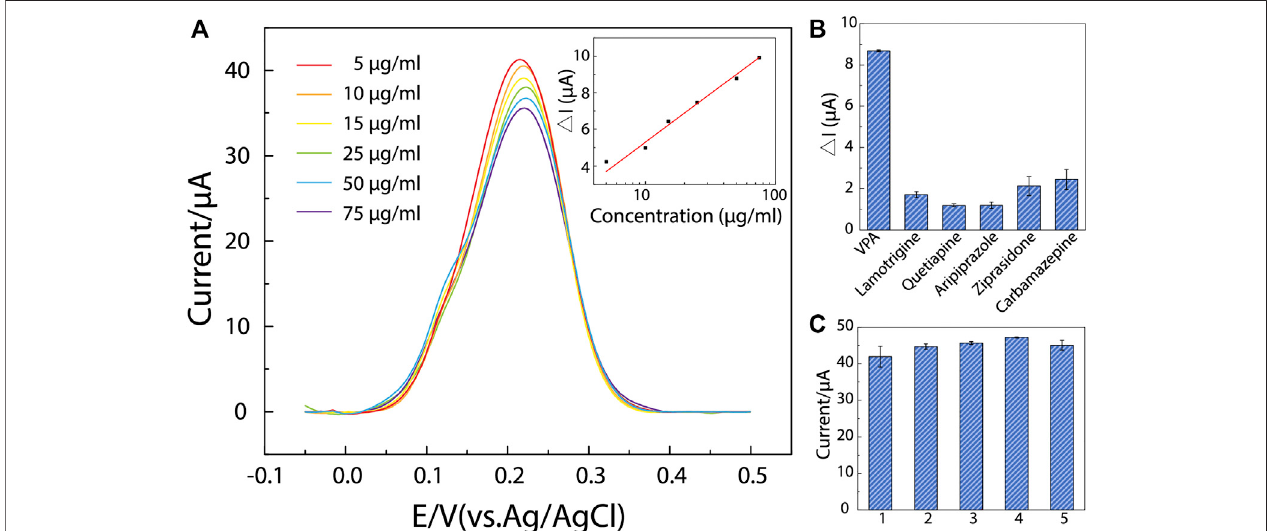
FIGURE 4 | The determination performance, selectivity, and uniformity of ppy@AuNPs-MIP sensor. (A) DPV responses on ppy@AuNPs-MIP sensors incubated in VPAsolutionswhoseconcentrationsrangedfrom5to75 μ g/ml(fromtoptobottom)for8 min.Theinset:linearitycurveof Δ IandVPAconcentration( R 2 =0.99). (B) DPV responses of VPA and interferents ( n = 3). (C) The designed sensors showed good uniformity ( n = 3). Error bars got from triplicate measurements on each modi fi ed